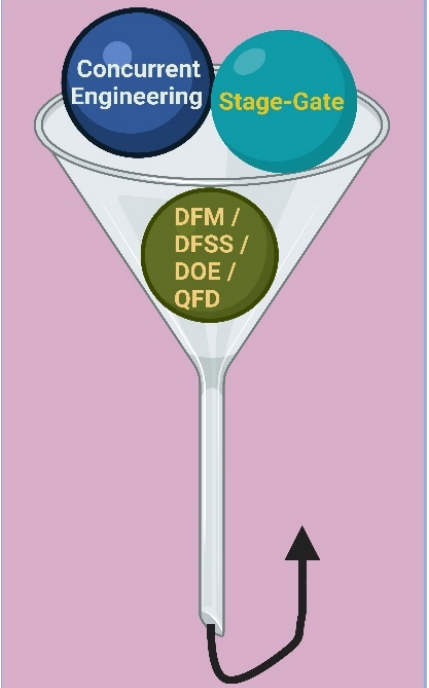
Figure 1. Current Medical device NPI Approach